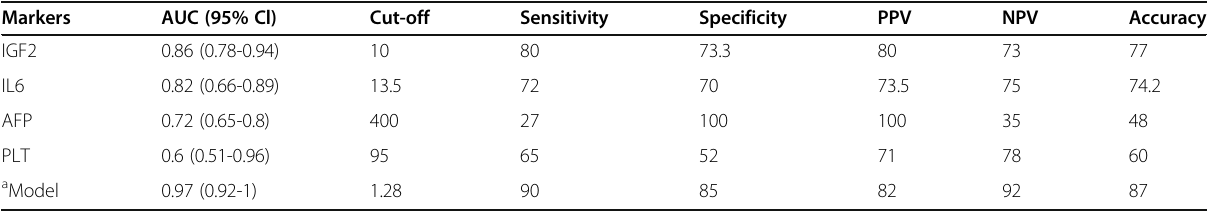
Table 2 Diagnostic power of investigated biomarkers and model for differentiating liver cirrhosis vs. HCC